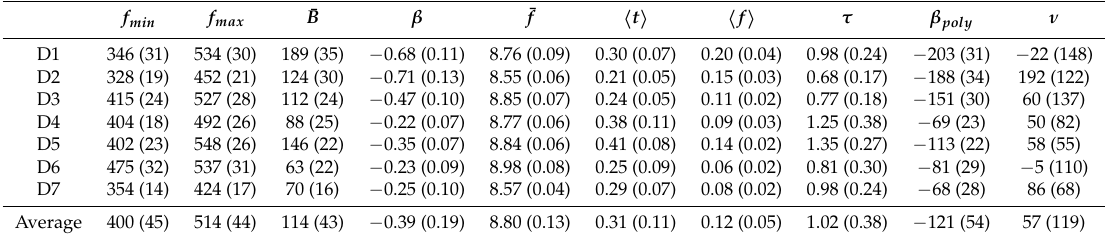
Table A1. Humpback D-moan sub-classification result for the NEGB direction. The quantity in parenthesis indicates the standard deviation. The D-moans from 1–3 October are analyzed here.